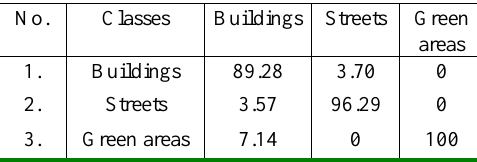
Table 4 . Ground truth for the image from 2017 Commission errors are calculated by reviewing the classified sites for incorrect classifications. This is done by going across the rows for each class and adding together the incorrect classification and divided them by the total number of classified sites for each class (Table 5, Table 6).